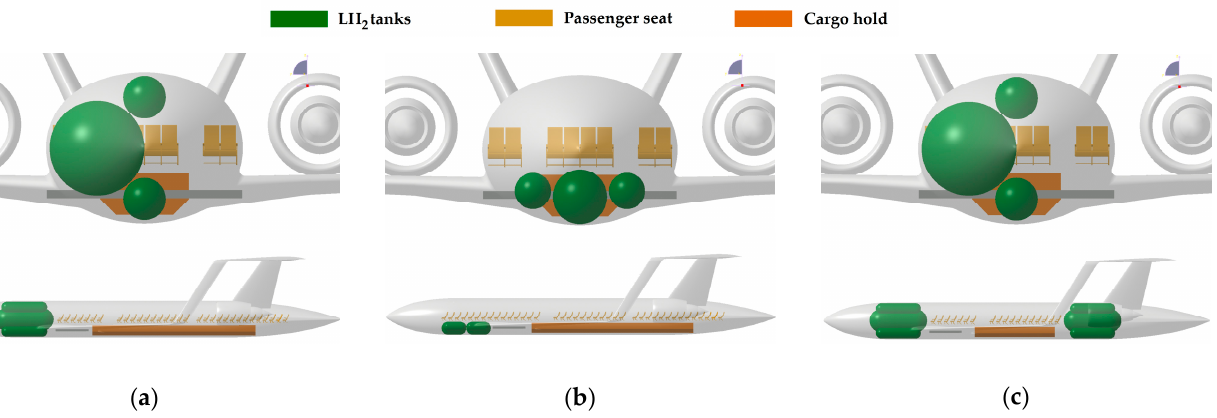
Figure 5. Illustration of possible tanks–fuselage integration layouts: ( a ) full-section with “catwalk”, ( b ) part-section with cargo deck occupation, ( c ) multiple groups of tanks (full-section case).